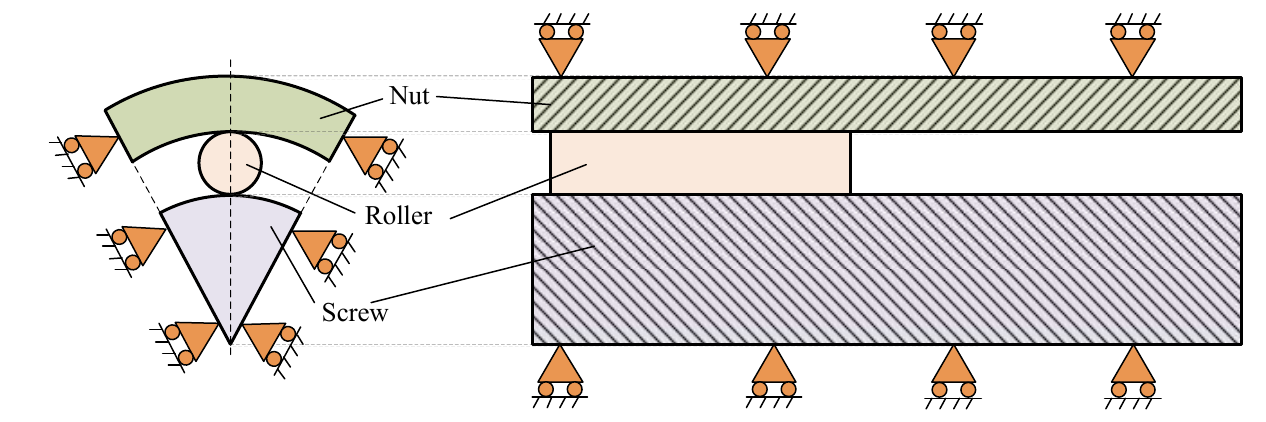
( b ) Figure 7. ( a ) Load and displacement of rectangular volume; ( b ) location and dimensions of rectan- gular volumes in Ref. [39]. Lisowski et al. [41] created a finite element model of the contact of the single pair thread in the PRSM and obtained the stress and thread deformation curve. They also pro- posed a load model of the PRSM with reference to the direct stiffness method. Lisowski et al. [42] then analysed the load distribution of the PRSM under the influence of random pitch error and calculated the stiffness coefficient of the interactions between the screw– roller and the roller–nut using the finite element method. In addition, Lisowski et al. [43] proposed an optimisation of thread root undercut in the PRSM. Using a three-dimensional